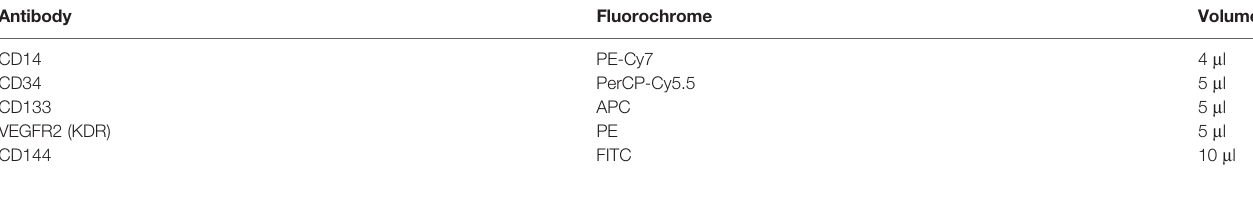
TABLE 1 | Antibodies are used for the enumeration of cEPCs and progenitor cells.